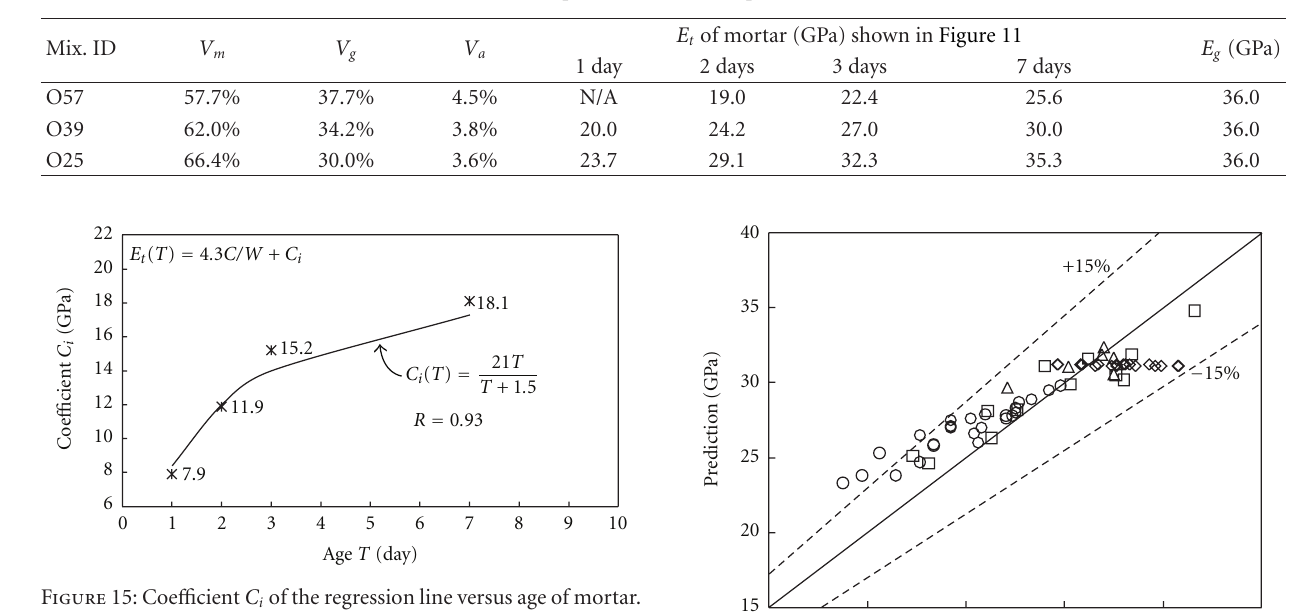
Table 4: Input data for the composite model.